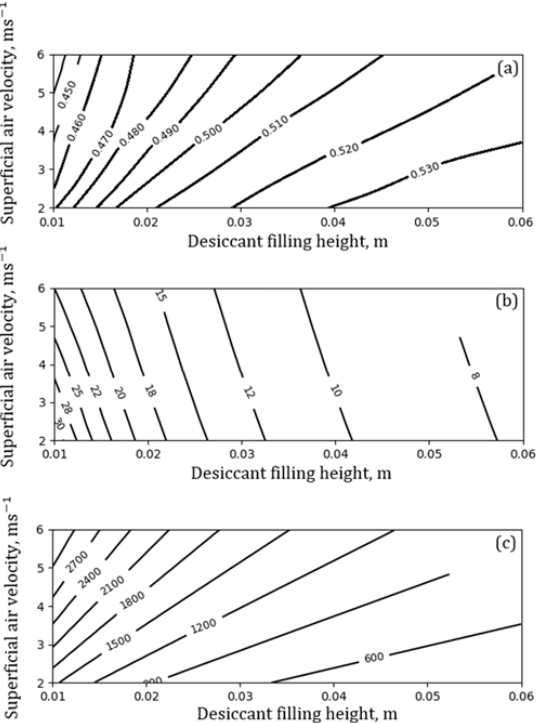
Figure 14. The influence of desiccant filling height and superficial air velocities during adsorption and desorption (both velocities are equal) on the performance of the FDC: ( a ) thermal COP ; ( b ) electric COP ; ( c ) SCP .